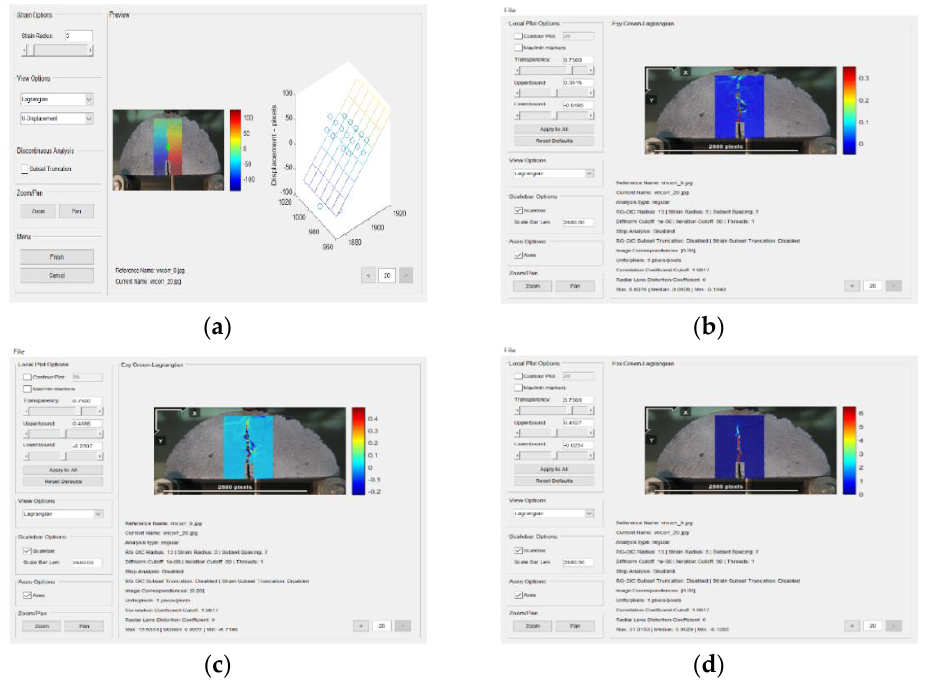
Figure 10. ( a ) Set a reasonable strain radius; ( b ) strain E xx ; ( c ) strain E yy ; ( d ) strain E xy .